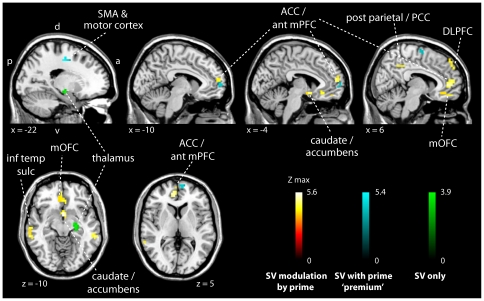
Regions in which activation for temporal discounting decisions was parametrically modulated by subjective value (SV).Using two parametric orthogonal regressors for SV and for the trial-by-trial interaction of priming and SV (see Materials and Methods), several regions were identified displaying the interaction, independent from general SV (‘priming interaction model’; displayed in yellow). These were anterior mPFC/ACC, mOFC, left PCC, the caudate nucleus/nucleus accumbens, inferior temporal sulcus, the IPS (not displayed) and medial occipito-temporal sulcus (not displayed). The only region, which encoded only SV but was not modulated by priming was the left thalamus (displayed in green). Regions displaying specific Apple prime modulation (‘priming premium model’; see Materials and Methods) of SV encoding were anterior mPFC, bilateral premotor cortex, and motor cortices (displayed in cyan). For MNI coordinates and statistics refer to main text.